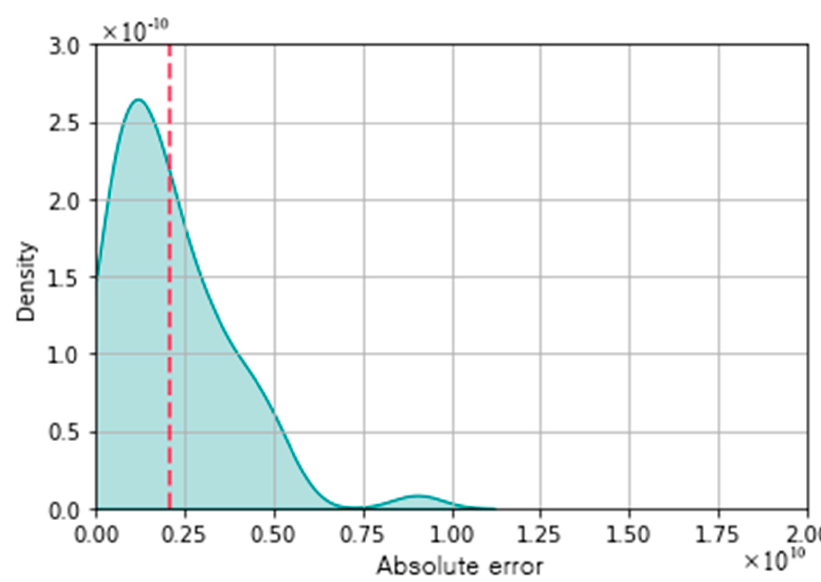
Figure 6. Error of single-factor model.